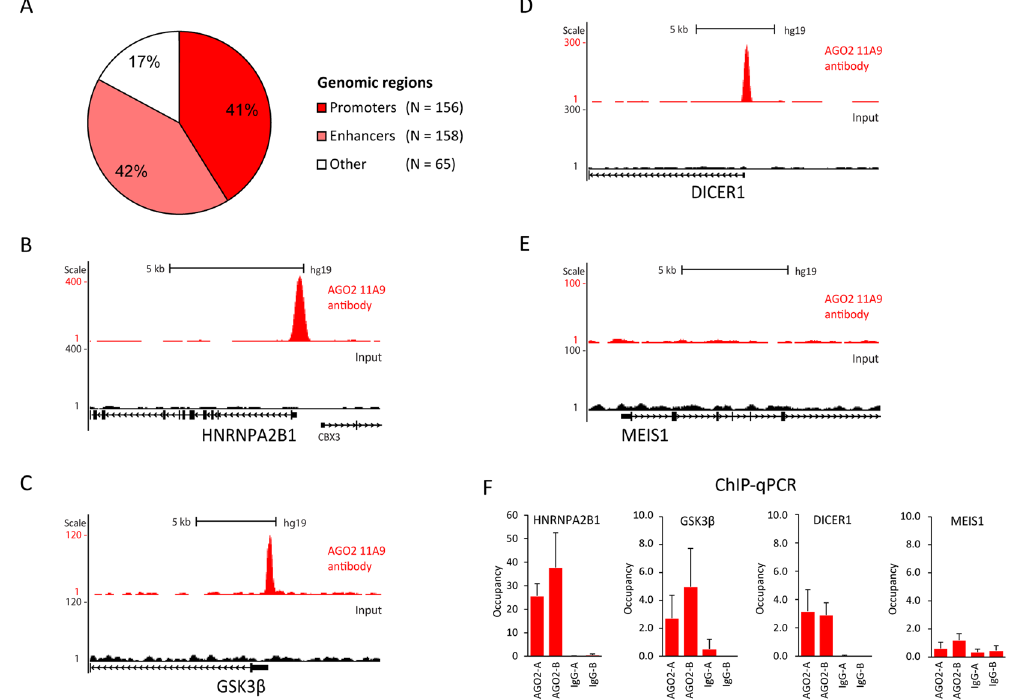
Figure 2. Chromatin immunoprecipitation with anti-AGO2 11A9 enriches promoters and enhancers in epidermal stem cells. ( A ) Alignment with promoters/enhancers regions with 379 best peaks obtained with MACS peak calling. ( B – E ) ChIP-seq in epidermal stem cells at the transcription start site of the indicated loci. ( F ) ChIP-qPCR in epidermal stem cells at the indicated loci. Meis1 is a negative region and occupancy represents enrichment over a heterochromatic region. A and B represent biological replicates and error bars represent standard deviations of 3 technical